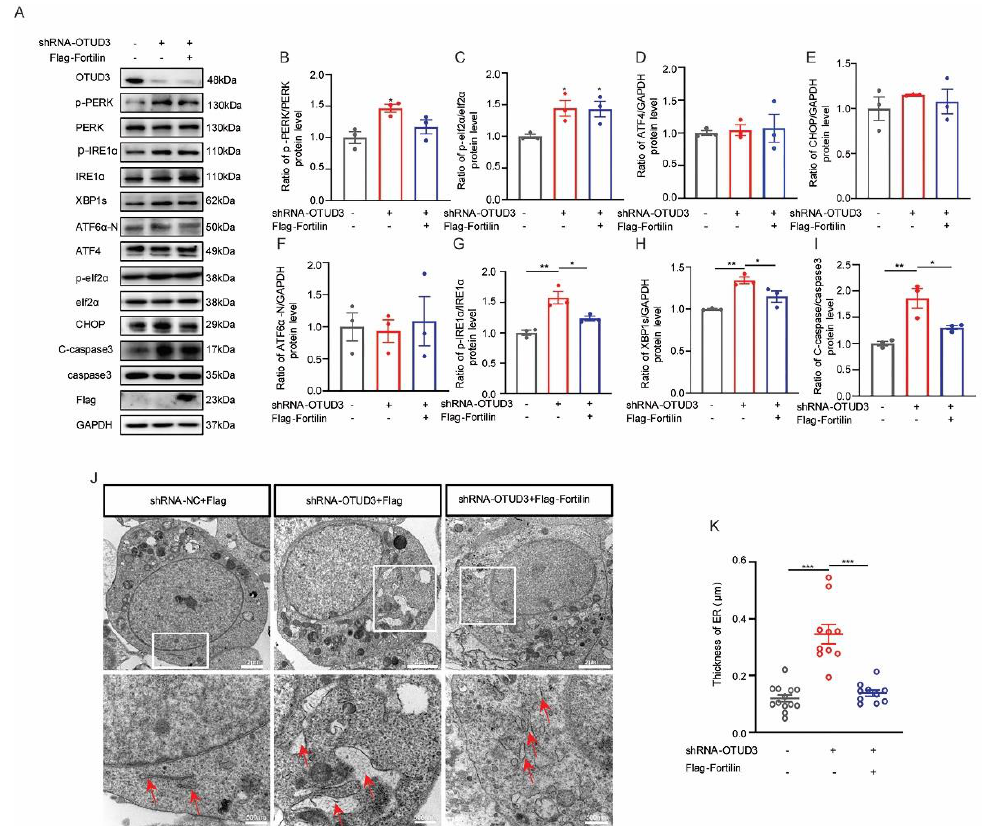
Figure 6. Fortilin alleviate ER stress induced by OTUD3 knockdown. ( A ) Western blotting to detect the ER stress-associated proteins expression. ( B – E ) Statistical analysis of the expression of PERK pathway-associated proteins after Fortilin overexpression in OTUD3 knockdown cells. n = 3. ( F ) Statistical analysis of the expression ATF6 α -N proteins after Fortilin overexpression in OTUD3 knockdown cells. n = 3. ( G – I ) Statistical analysis of the ratio of p-IRE1 α /IRE1 α , cleaved-caspase 3/caspase 3 and the expression of XBP1s after Fortilin overexpression in OTUD3 knockdown cells. ( J , K ) Transmission electron microscope was applied to assessment of ER shape and statistical analysis of ER lumen after Fortilin overexpression, n = 10, 12; red arrows represent the ER. Data were mean ± SEM, t -test, * p < 0.05, ** p < 0.01, *** p < 0.001.